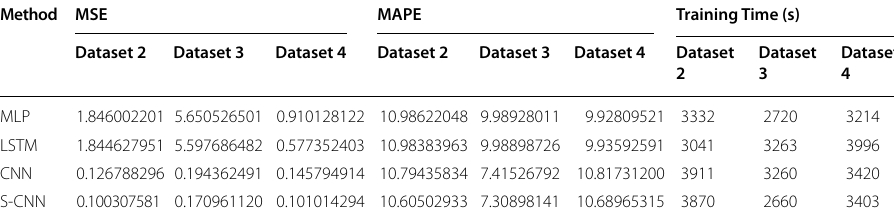
Table 12 Comparison with others